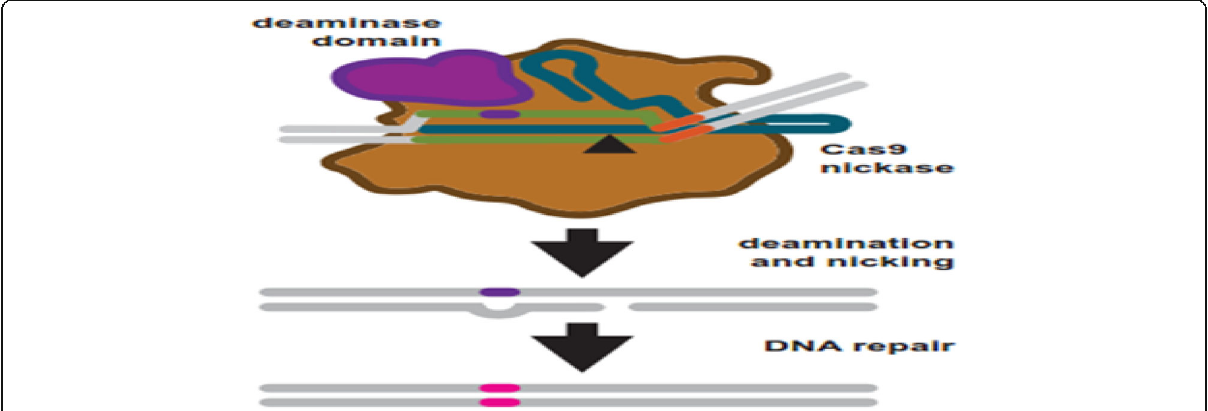
Fig. 5 Base editing uses engineered Cas9 variants to induce base changes in a target sequence. Cas9 nickase is fused to a base deaminase domain. The deaminase domain works on a targeted region within the R-loop after target binding and R-loop formation. Simultaneously, the target strand is nicked. DNA repair is started in response to the nick using the strand which contains the deaminated base as a repair template. Repair leads to a transition mutations: C:G to T:A and A:T to G:C for cytosine and adenosine base editors, respectively [68]